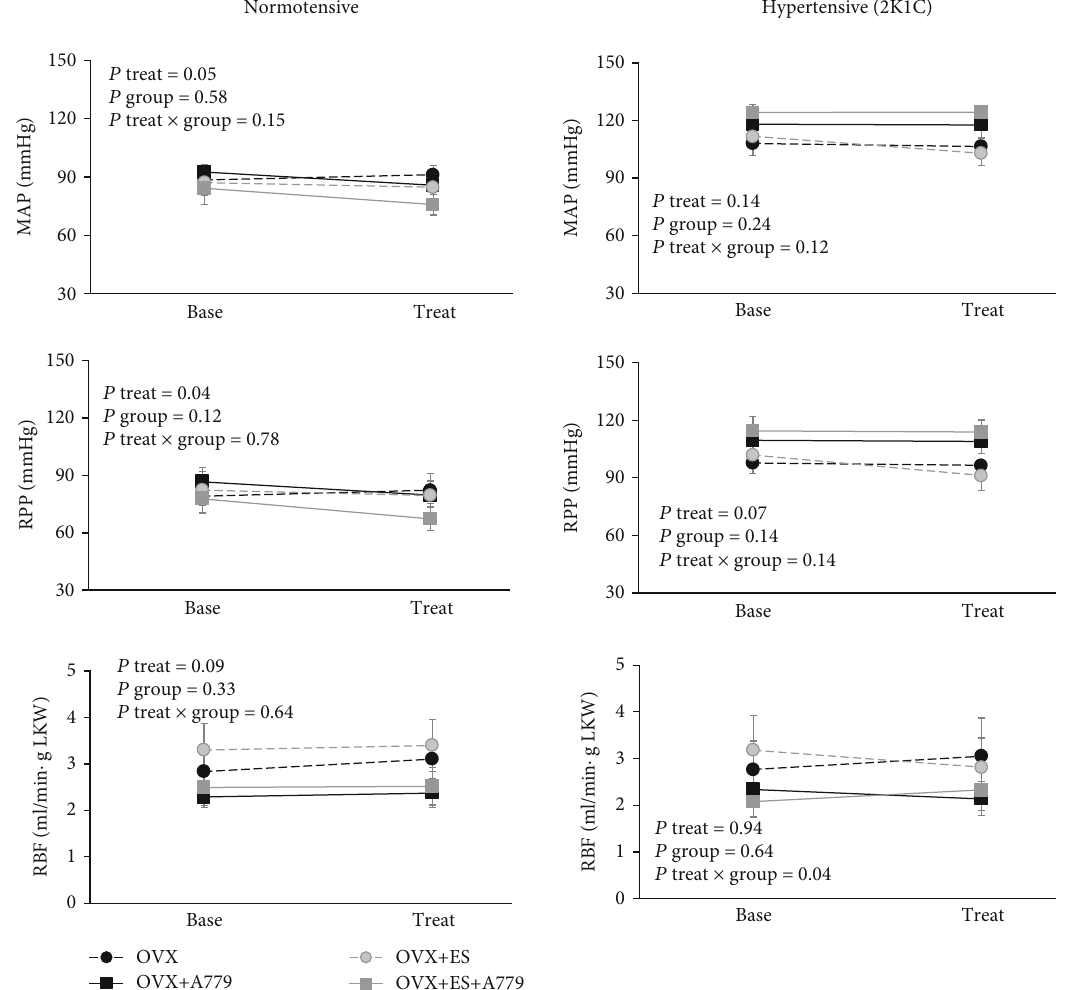
Figure 1: The antagonist or its vehicle e ff ects: hemodynamic variables before and after administration of A779 or its vehicle in two models of normal and 2K1C ovariectomized rats treated with estradiol or its vehicle. Data are presented as the mean ± SEM . The P values were derived from repeated-measures ANOVA with factor treatment, group, and their interactions. MAP: mean arterial pressure (mmHg); RPP: renal perfusion pressure (mmHg); RBF/LKW: renal blood fl ow per gram left kidney weight (ml/min · g). OVX, ES, and A779 stand for ovariectomized rats, estradiol treatment, and Mas receptor antagonist administration,